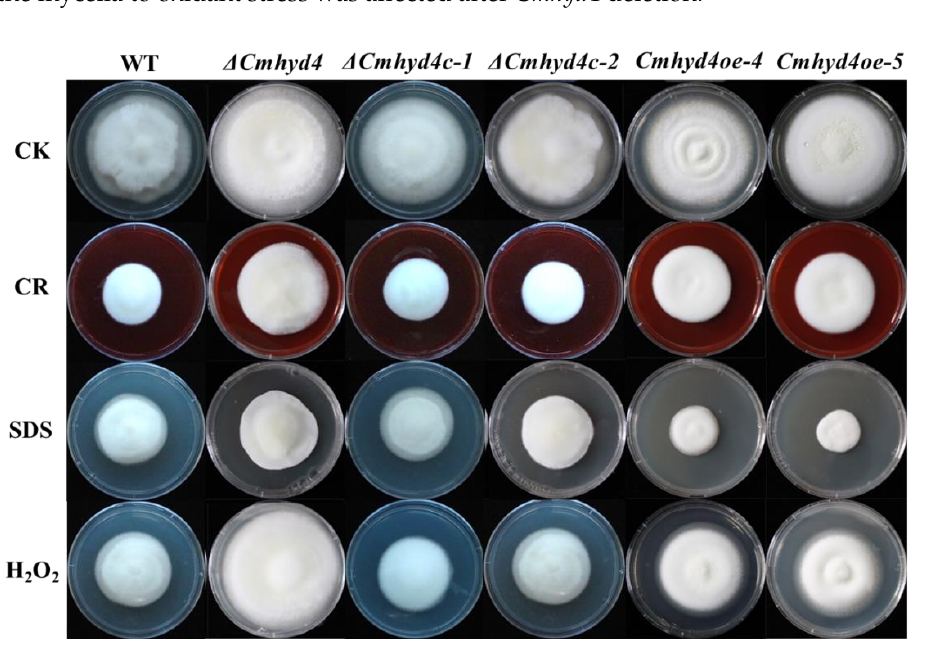
Figure 5. The stress response of mycelia in the WT and mutant strains. As the control, CK was inoculated on PDA medium. CR, SDS, and H 2 O 2 represent the PDA with 10% congo red, 0.1% SDS, and 0.075 mM H 2 O 2 . All the strains were cultured at 20 °C for 21 d in darkness and then photographed. The experiments were repeated three times with similar results.